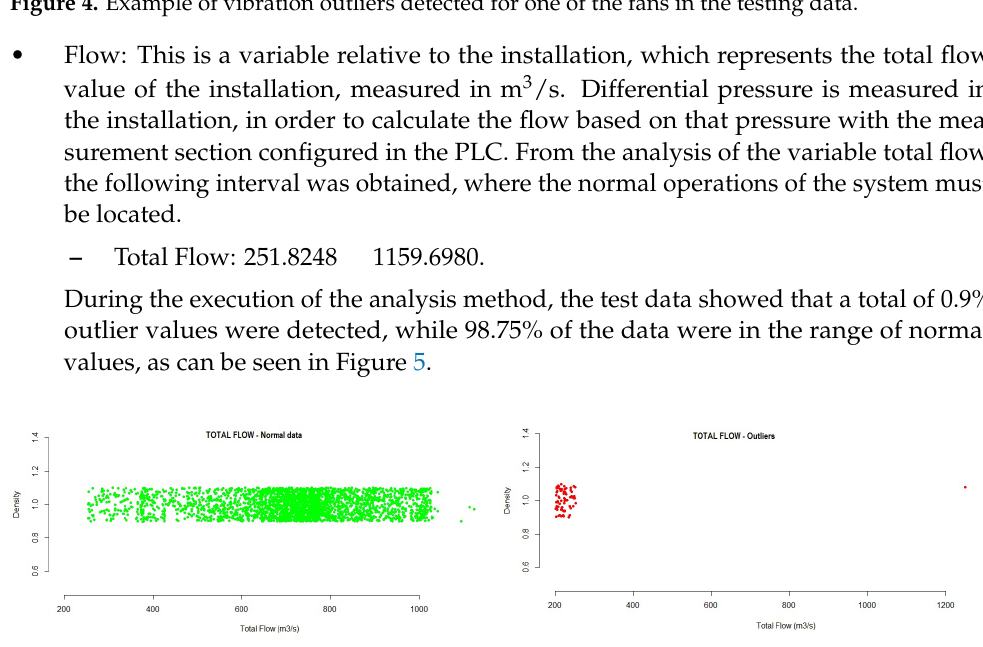
Figure 4. Example of vibration outliers detected for one of the fans in the testing data.